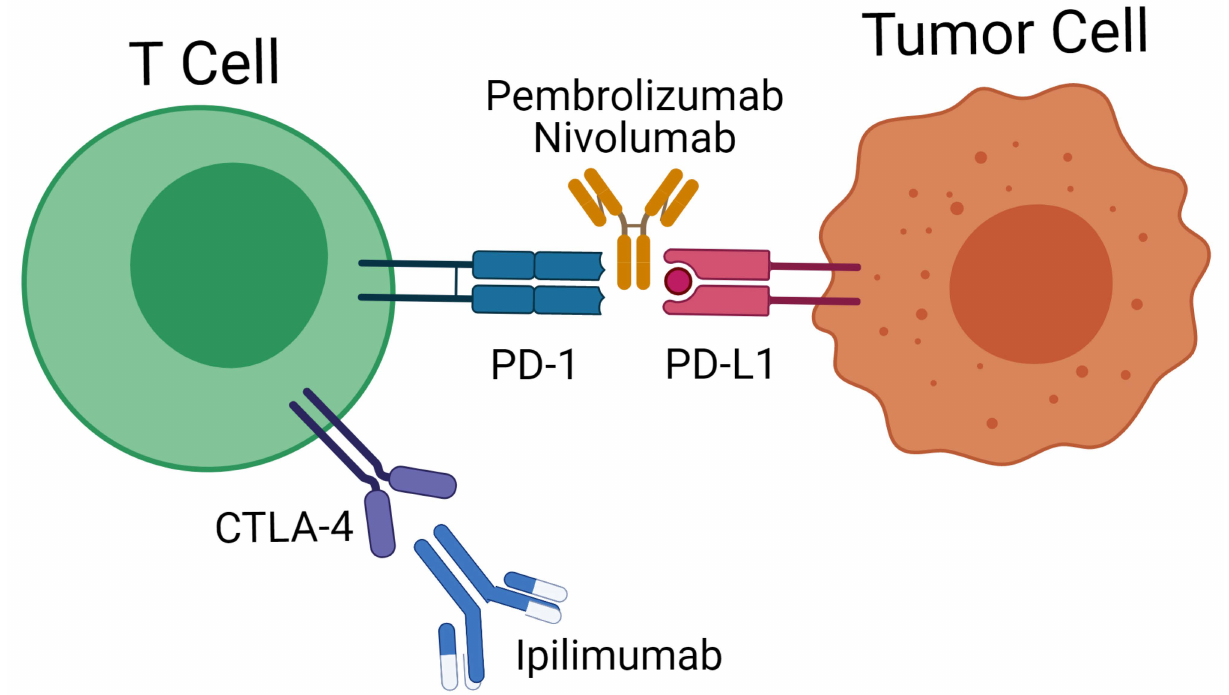
Figure 3. Immune checkpoint inhibition using anti-PD-L1 antibodies in clinical use such as nivolumab and pembrolizumab. In addition, anti-CTLA4 therapy involving ipilimumab has also been considered in PA